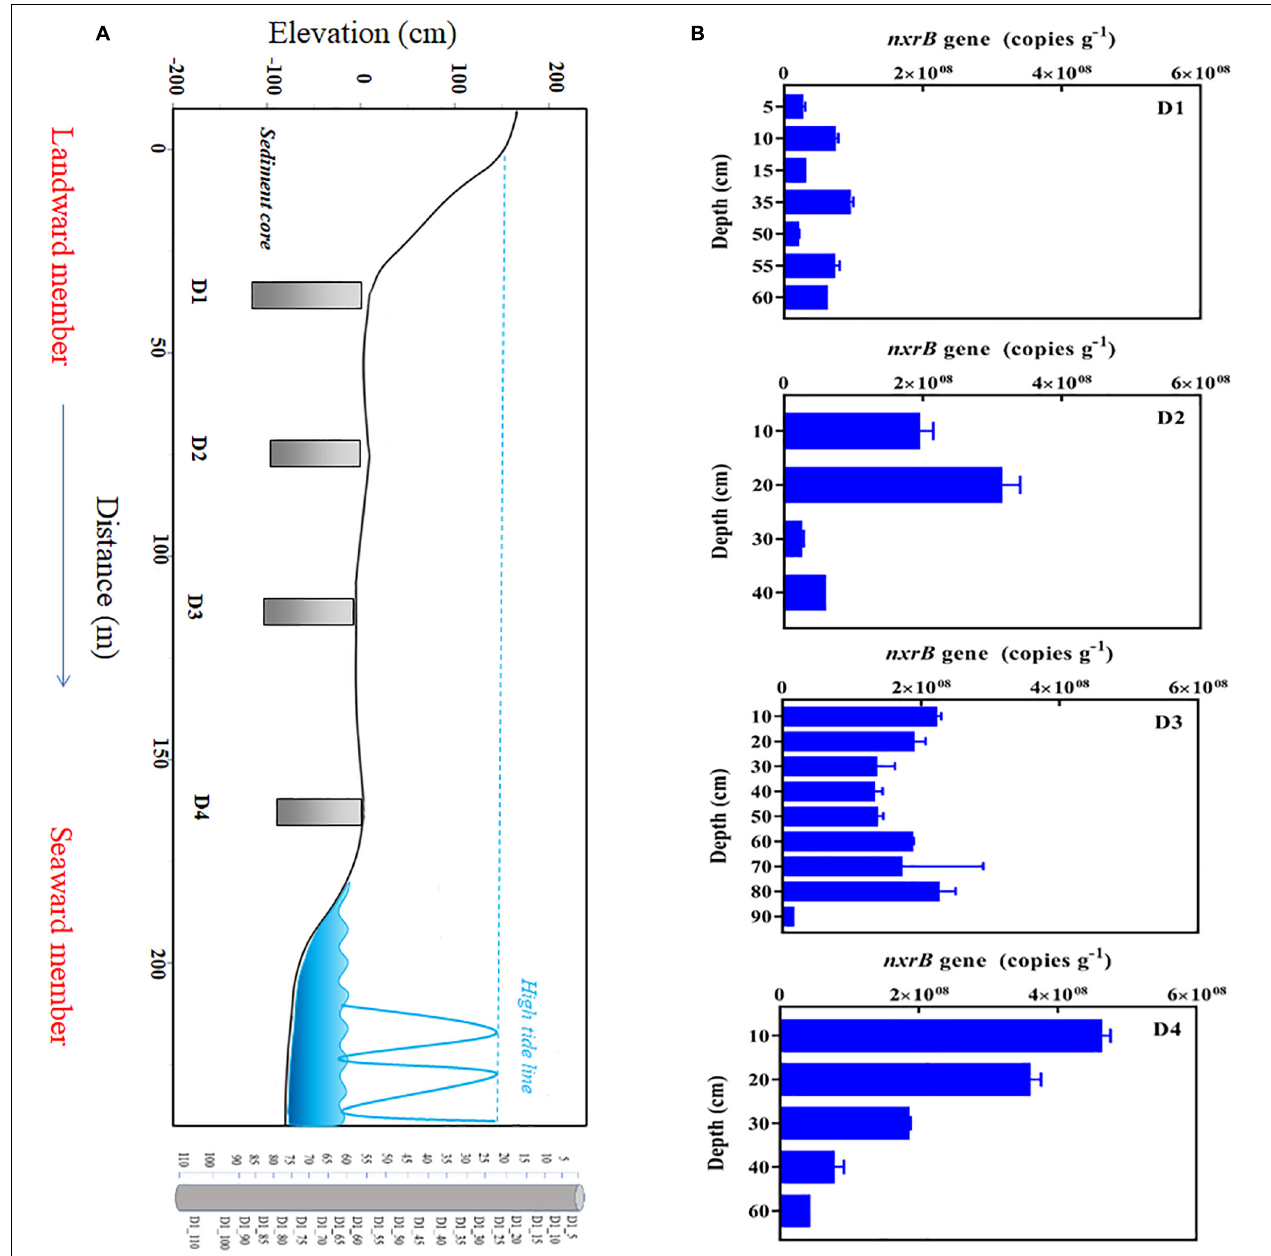
FIGURE 1 | Sampling sites (A) and nxrB gene abundance of Nitrospira the DYB (STE) (B) . D1, D2, D3, and D4 (from landward member to seaward member) stands for sediment cores with a depth of 110, 90, 90, and 80 cm, respectively. As shown in core D1, eveiy 5 cm sediment section was mixed as one sample named from D1_5 to D1_90, while eveiy 10 cm sediment section from 90 to 110 cm respectively named D1_100 and sample D1_110. For core D2, Core D3 and core D4, eveiy 10 cm sediment section was mixed as one sample with the same naming policy.